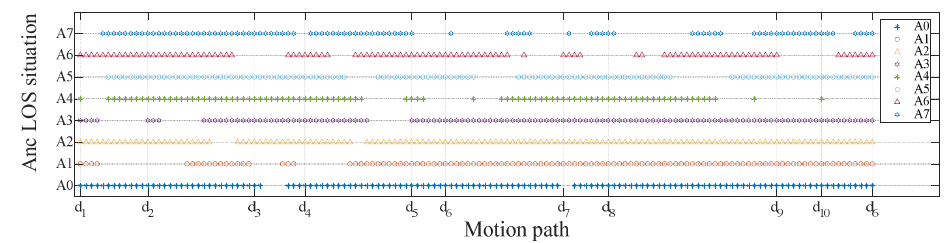
Figure 10. Experimental path LOS situation of anchors.